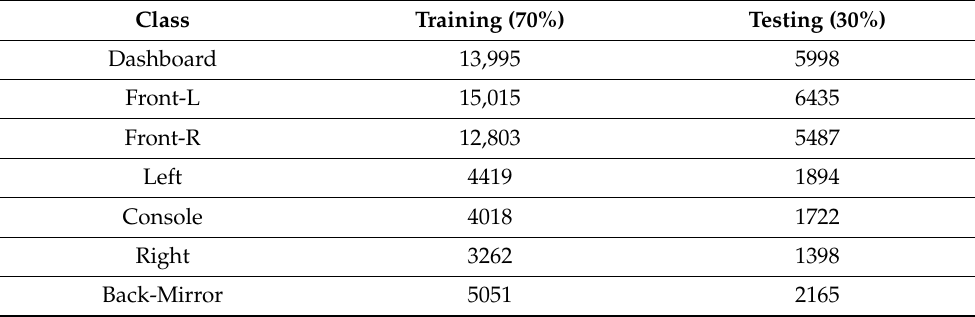
Table 1. Custom gaze detection dataset details.